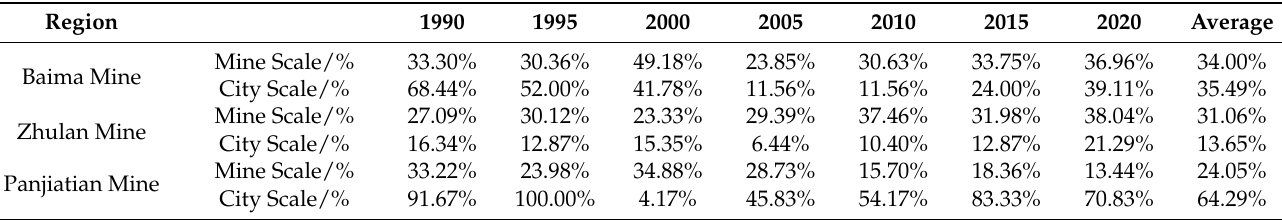
Table 2. Not Significant Area of the Mine.